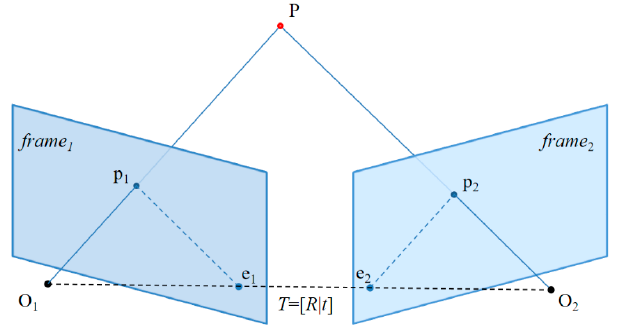
Figure 8. Diagram of the epipolar constraint.